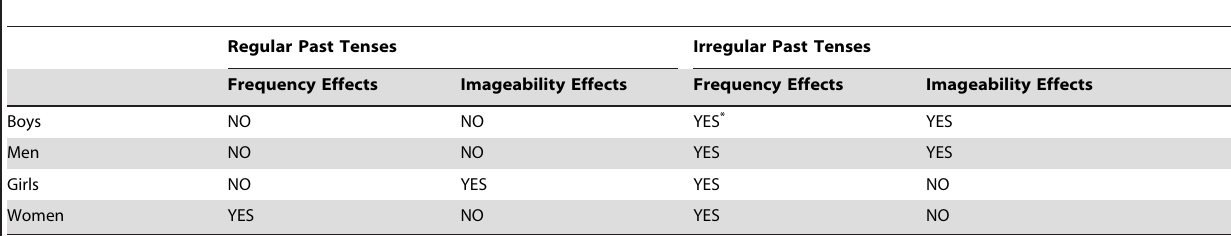
Table 2. Summary of frequency and imageability effects, by verb type, sex and age